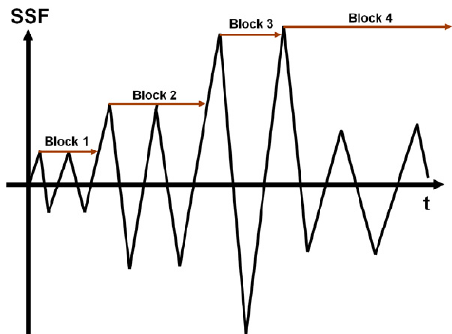
Figure 11: Block extraction methodology for random